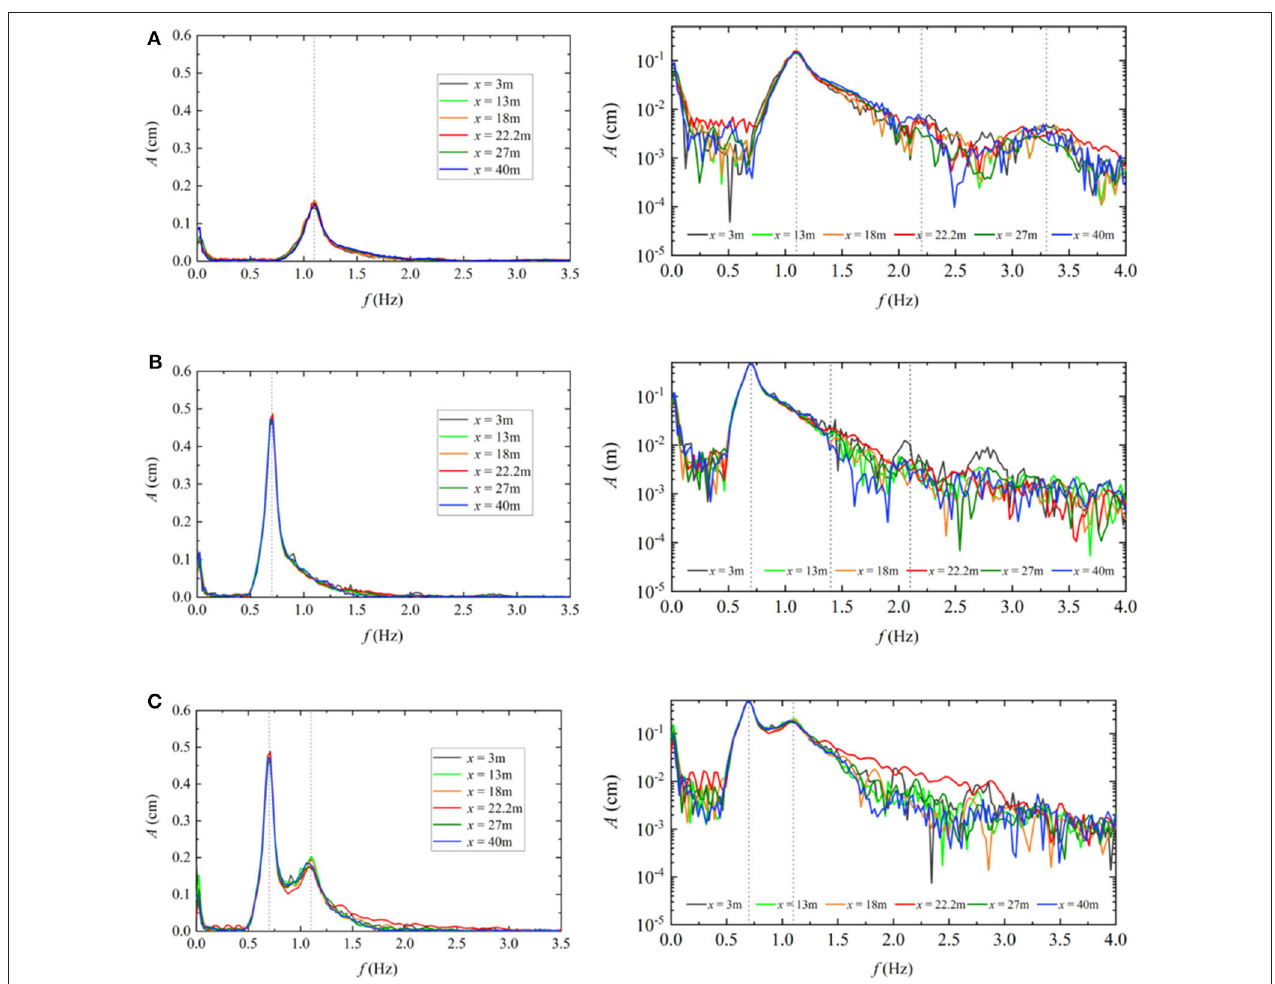
FIGURE 6 | The amplitude spectra at different locations along the wave flume for (A) Case 1_A, (B) Case 1_B, and (C) Case